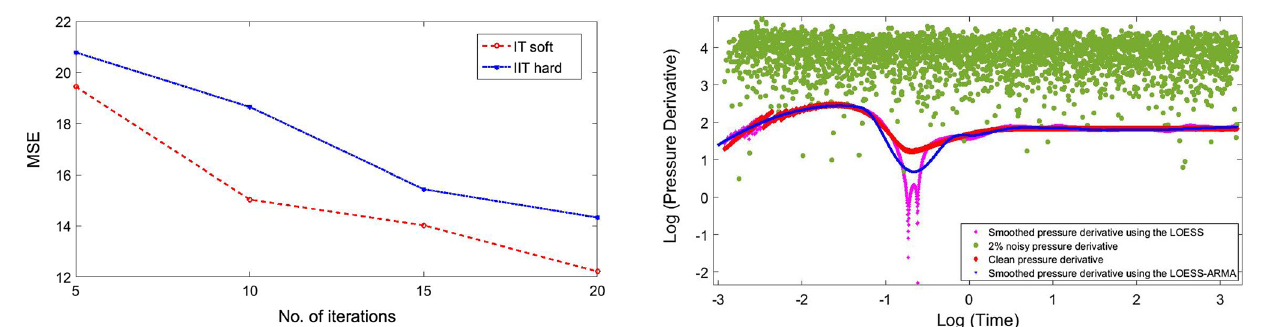
Fig. 13 (Red) the calculated pressure derivatives from clean noise- free pressure data; (green) the calculated noisy pressure deriva- tives from 2% noisy pressure data; (magenta) the smoothed pressure derivatives, calculated by applying the LOESS filter; and (blue) the smoothed pressure derivatives, calculated by applying the combined LOESS and ARMA filters to the noisy pressure data